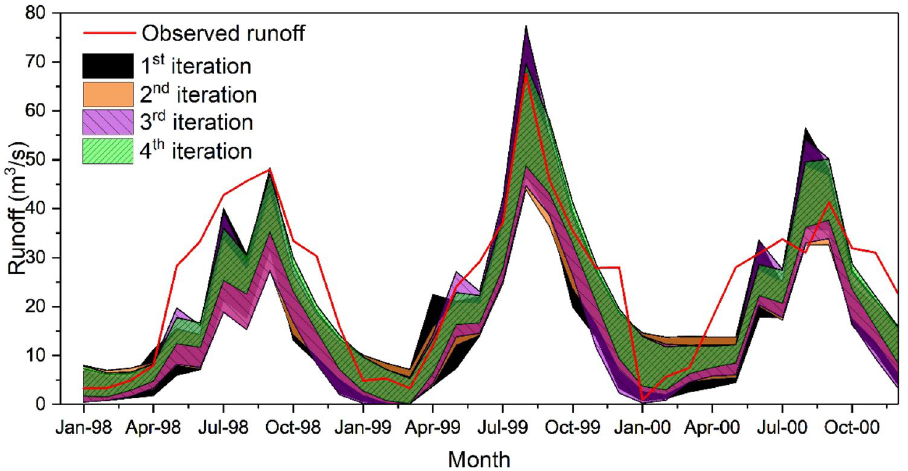
Figure 3. The 95PPU of surface runoff for four iterations using the MS-CUA